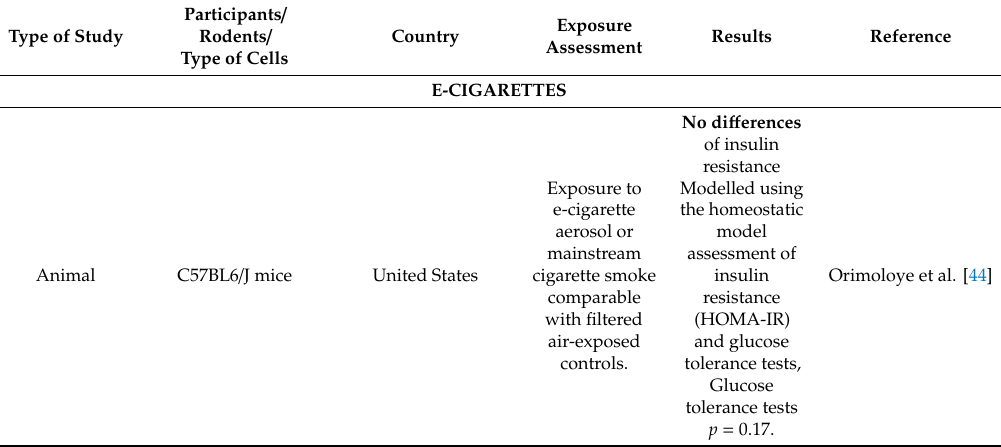
Table 3. The impact of electronic cigarettes use and tobacco smoke exposure on insulin resistance and